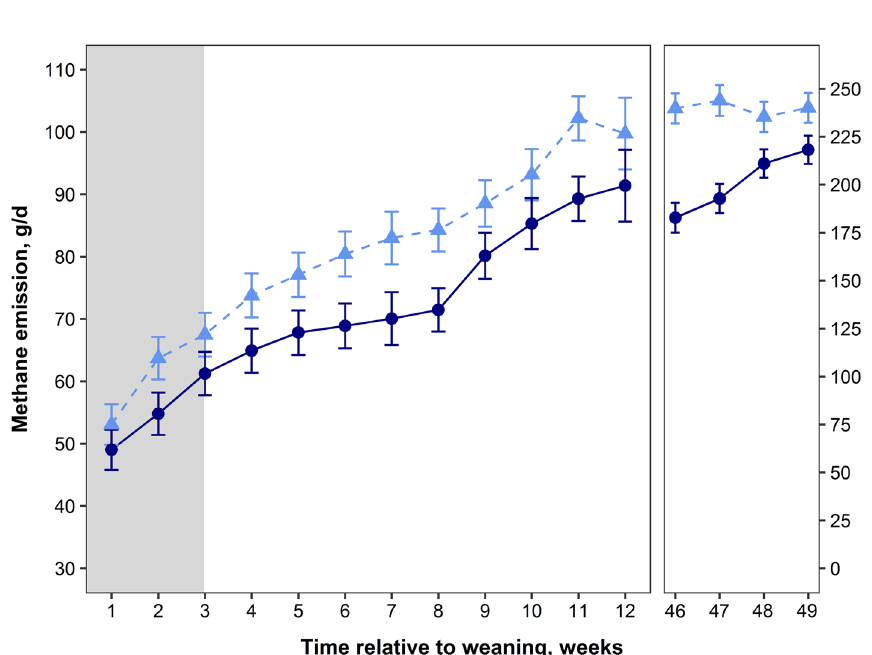
Figure 1. Methane emissions (g CH 4 /d) of weaned calves were persistently reduced with supplementation of 3-NOP. Control calves are represented by the light blue dashed line with triangles. Calves supplemented with 3-NOP until 14 weeks of life are represented by the navy blue line with circles. The grey shaded area represents the post-weaning treatment period. Methane emissions were measured using the GreenFeed System (C-Lock, Inc.). Data are treatment means and bars represent SE (n = 8 in CONT; n = 10 in 3-NOP group up to week 23, n = 9 for the measurement at 46–49 weeks post-weaning (57–60 weeks of life) due to the removal of a 3-NOP heifer from the herd due to infertility as a result of being born a twin, i.e., a